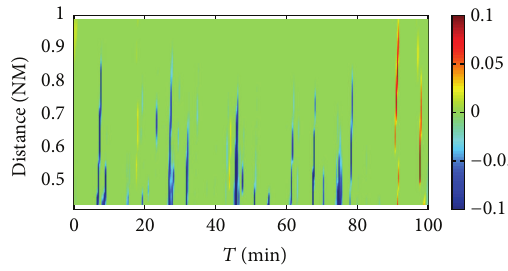
Figure 8: Hovmoller diagram of the filtered diagnostic field along the runway 25RA. The distance is from runway threshold in nautical